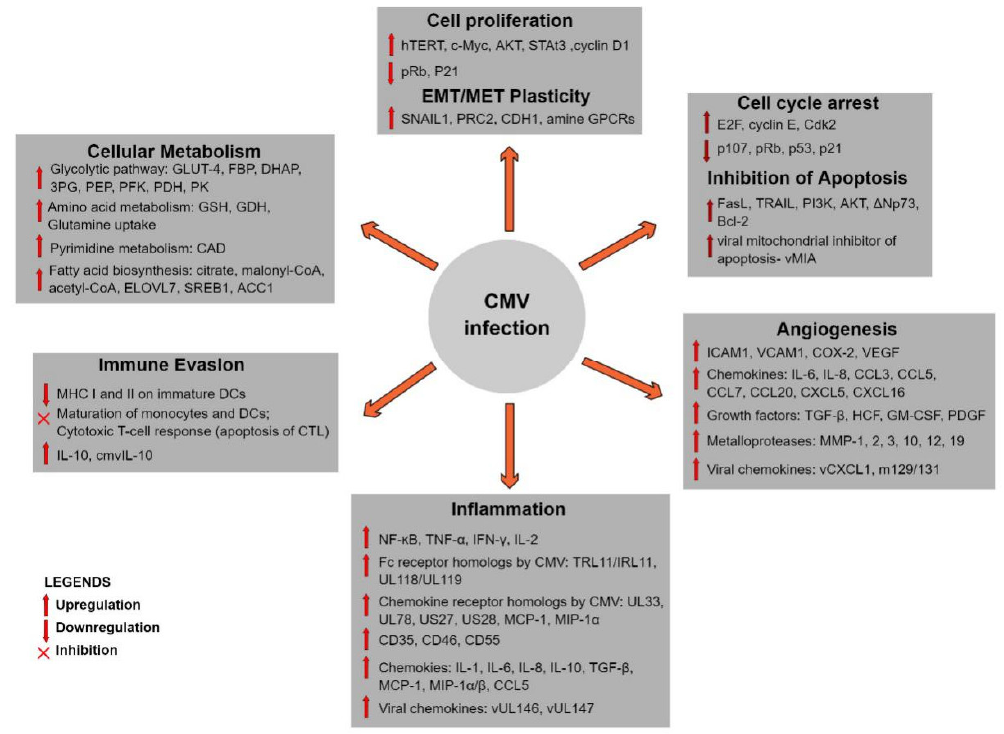
Figure 2. Signaling pathways deregulated during cytomegalovirus (CMV) infection. CMV may function as an oncomodulator to drive carcinogenesis. It seems to regulate the expression of proteins participating in cell proliferation, cell cycle arrest, cellular metabolism, apoptosis, angiogenesis, inflammation, immune suppression, and EMT plasticity [153–161]. It also codes for proteins that function as homologs for human proteins (such as chemokine receptors, Fc receptors, inhibitor of apoptosis).